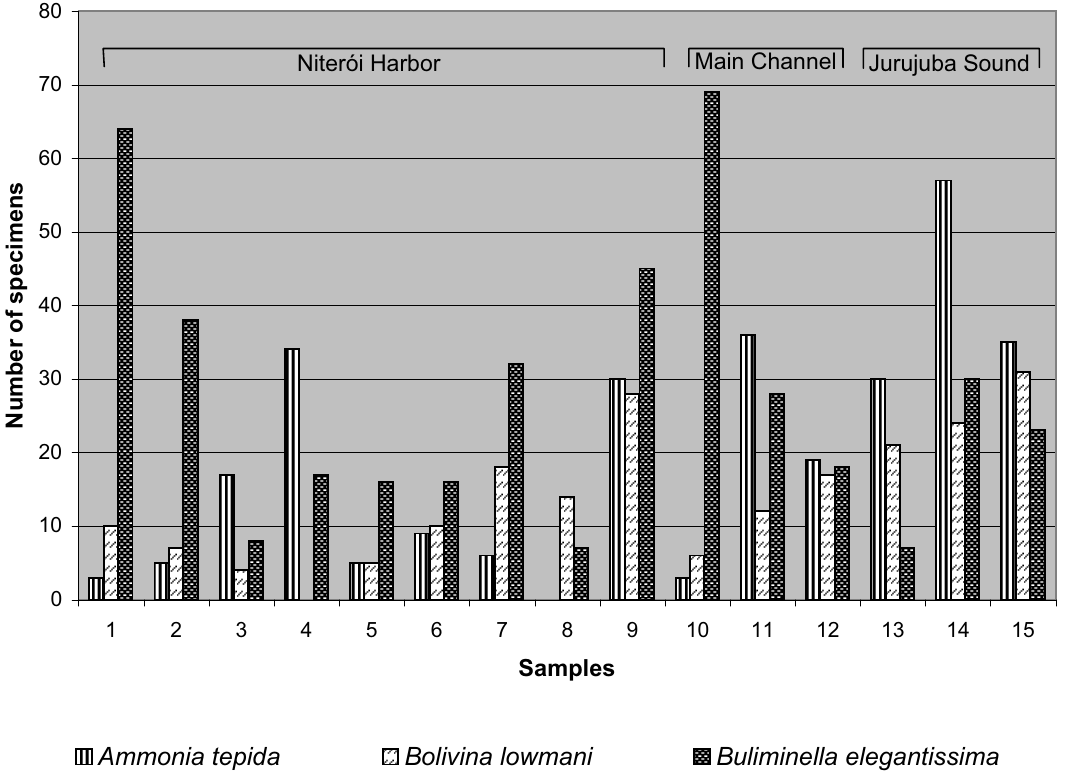
Fig. 5 – Benthic foraminifera relative abundance (for 100 specimens) of the dominant species in samples from Niterói, Guanabara